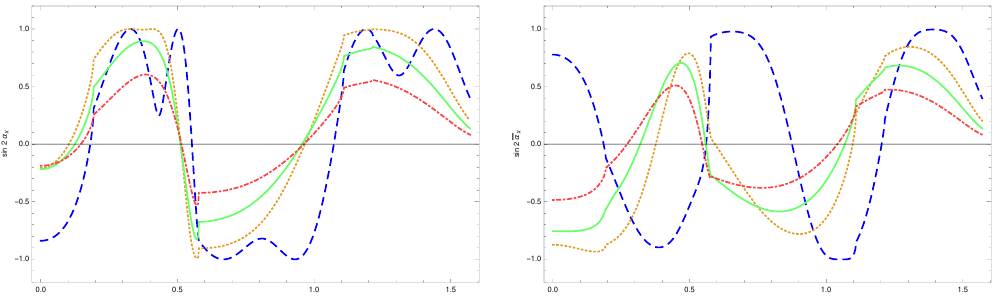
Figure 6 . sin 2 (cid:11) X and sin 2(cid:22) (cid:11) X plotted as a function of the azimuthal angle varied from 0 to (cid:25)= 2 for neutrino energies E = 200 MeV (blue dashed line), E = 400 MeV (orange dotted line), E = 600 MeV (green solid line) and E = 1000 MeV (red dot-dashed line). Normal mass ordering is assumed.